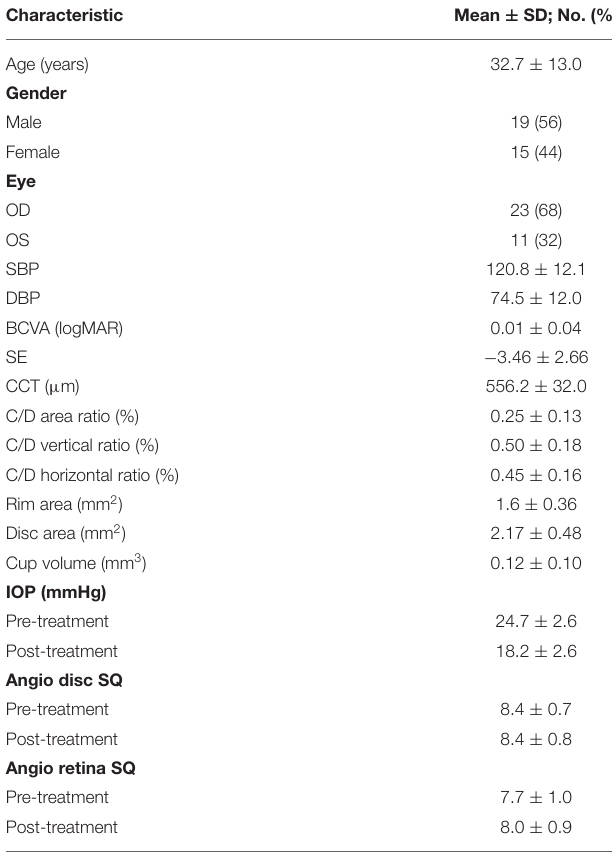
TABLE 1 | Demographics of the participants ( N =